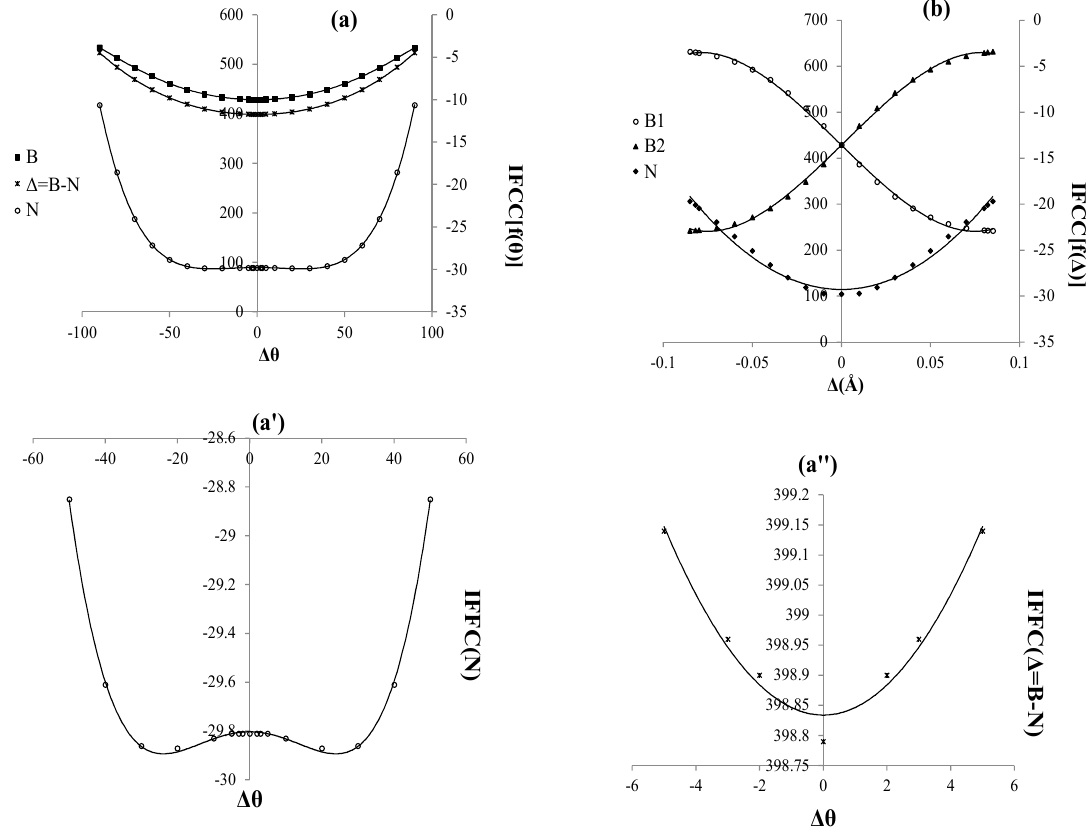
Figure 3. Isotropic Fermi contact coupling (IFCC) of B 2 N (0) : ( a ) Function of angles changing; ( b ) Function of distances changing. The axes for nitrogen and borons have different scales; ( a ′ ) IFCC for Nin a short scale between − 30 to − 29.8 indicates of IFCC breaking and ( a ′′ ) different IFCC of B and N in a short scale.